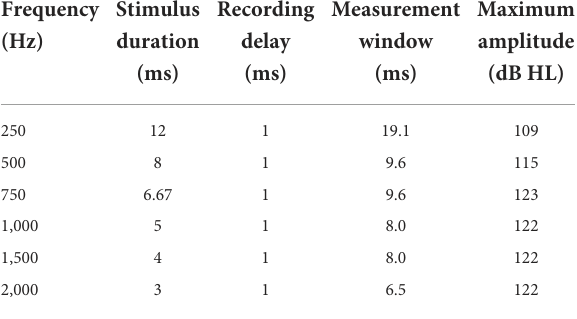
TABLE 2 Settings for acoustic stimulation and maximum possible acoustic stimulation level (maximum amplitude). Frequency Stimulus Recording Measurement